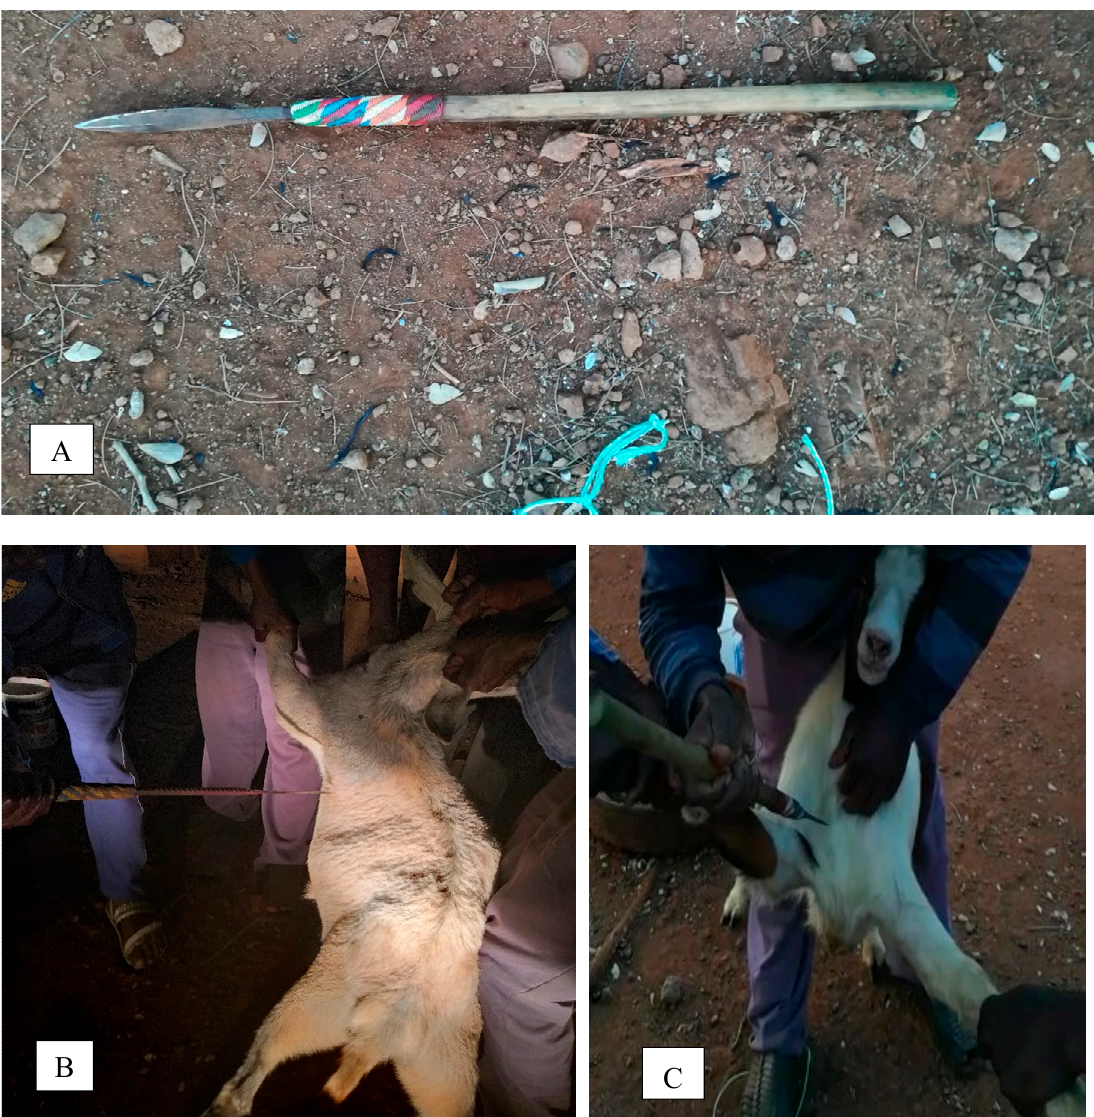
Figure 1. Visual pictures of a spear ( A ), suprasternal notch piercing ( B ), and chest-floor point-of-elbow piercing ( C ).